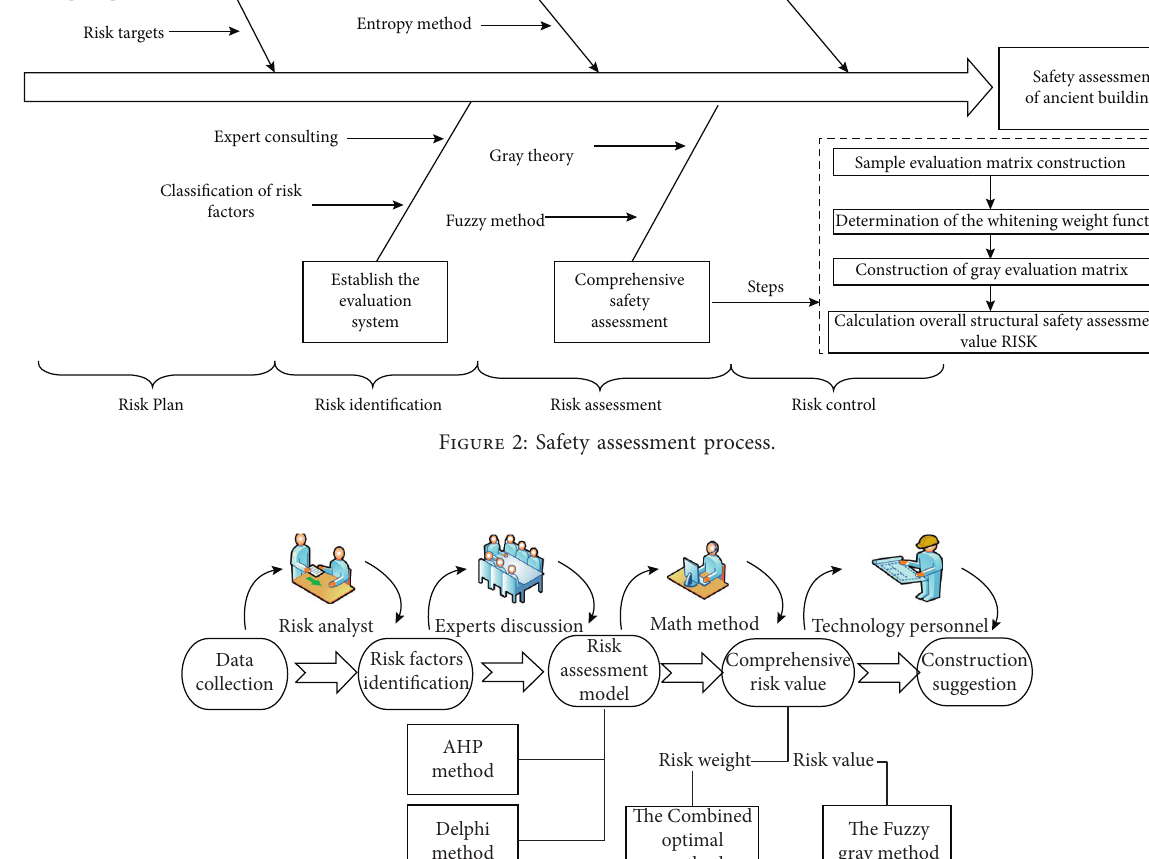
Figure 3: Specific